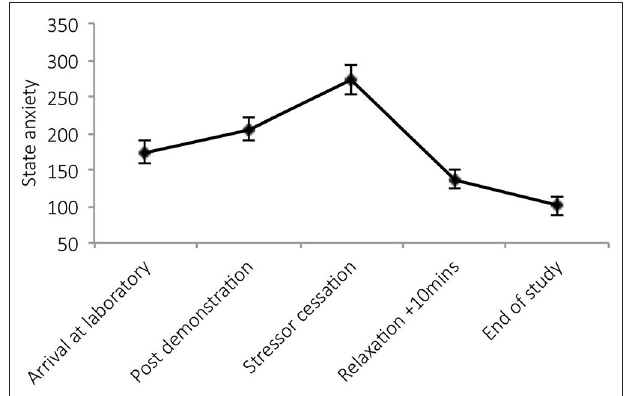
FIGURE 4 | Mean (and SE) state anxiety, assessed during exposure to the stressor